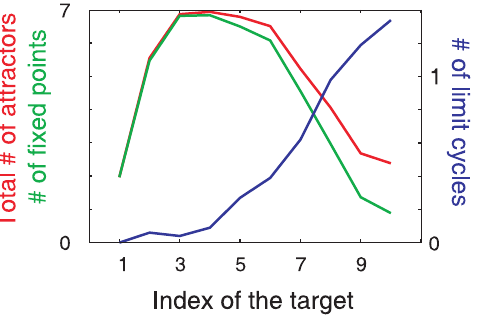
Figure 10. Change in the number of attractors during the learning process. Numbers of fixed-point attractors (green line) and limit-cycle attractors (blue line) and the total number of attractors (red line) in the absence of inputs as a function of the number of learning steps, i.e., number of learned targets, are plotted. In the early stages of the learning process, the number of fixed-point attractors increases, while in the later stage (after 5 or 6 learning steps), the number of fixed- point attractors decreases (fixed-point attractors are replaced by limit- cycle attractors).